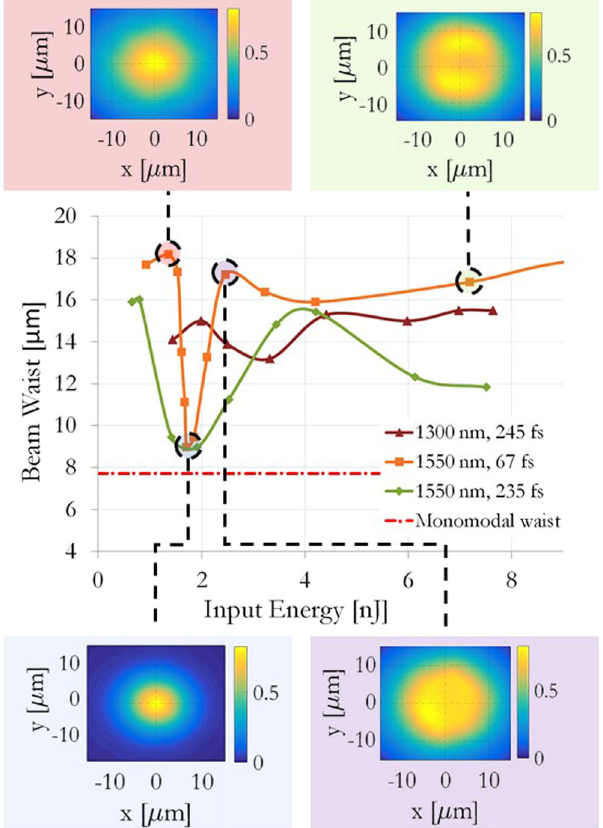
Fig. 2 Measured soliton beam waist vs. input pulse energy, after 120 m of graded-index (GRIN), in the same conditions of Fig. 1. The insets show the measured output near- fi elds, for an input wavelength 1550 nm and pulsewidth 67 fs. Infrared (IR) camera resolution is 0.25 μ m, which is too small to be visible at this scale.